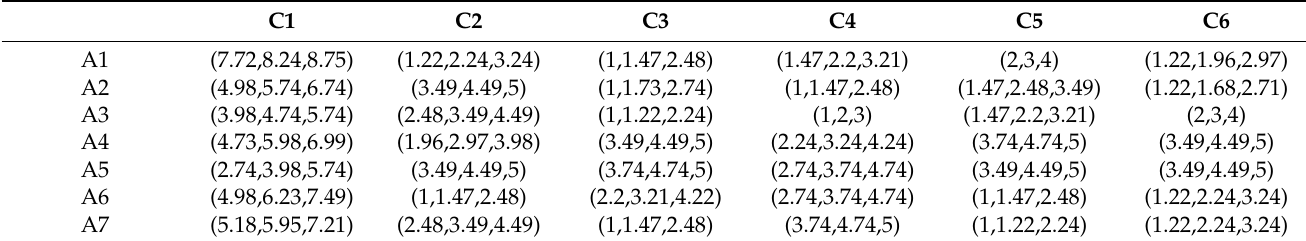
Table 6. Initial (aggregated) decision-making matrix (cid:101) X .